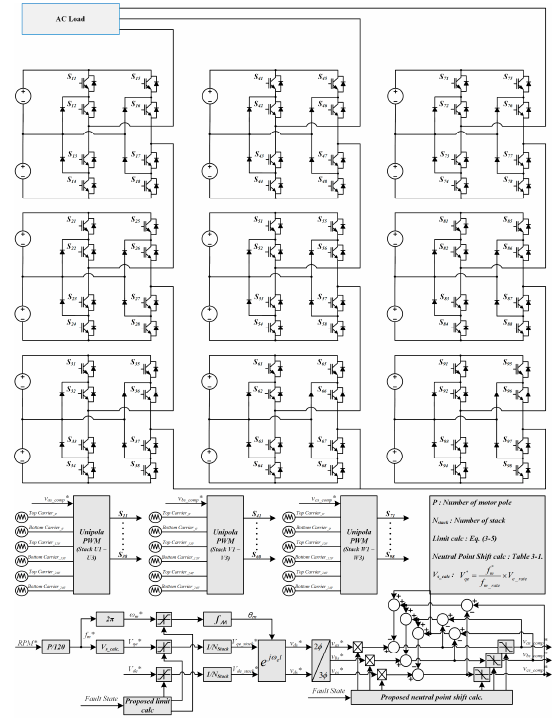
Figure 13. Control block diagram of one stack used in cascaded NPC/H-bridge system. Electronics 2018 , 7 , x FOR PEER REVIEW